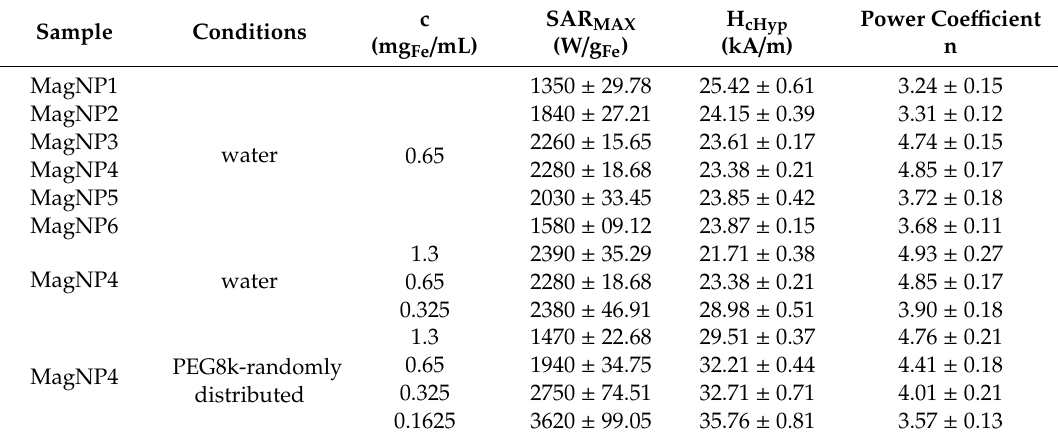
Table 3. Fitting parameters of SAR evolution with AC magnetic field amplitude